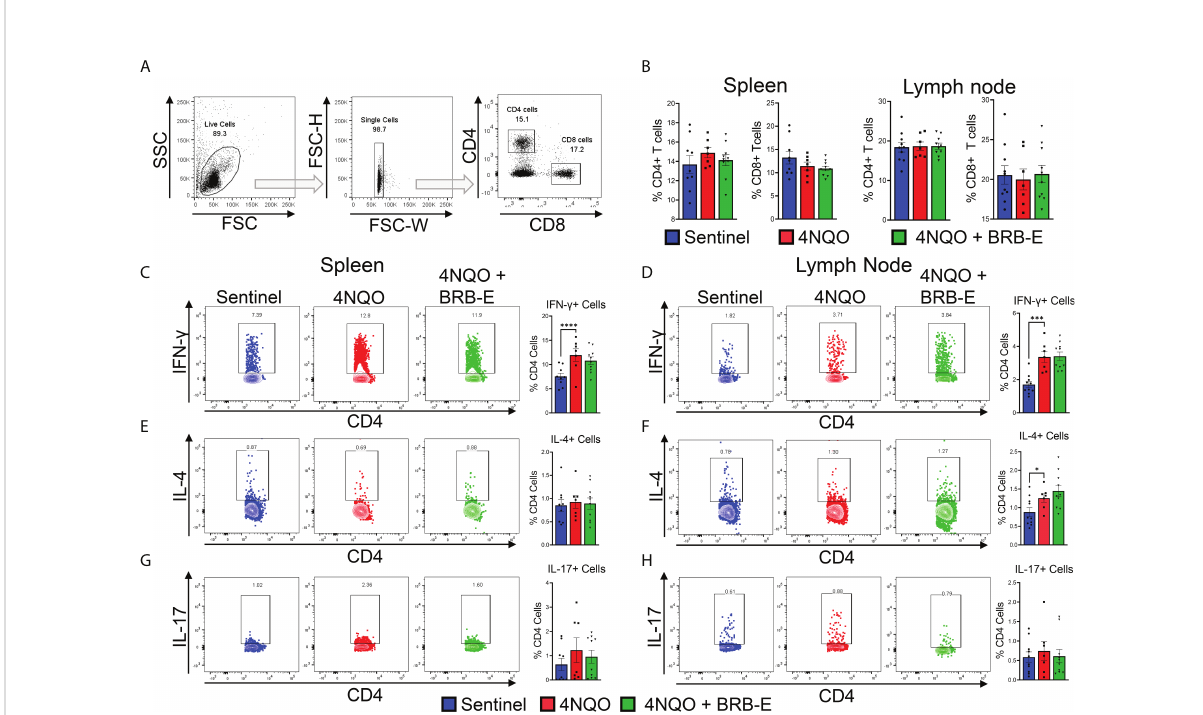
FIGURE 2 Effect of black raspberry extract on CD4 T-cell differentiation during HSNCC chemoprevention. (A) Gating strategy utilized to identify CD4 + and CD8 + T cells from the draining cervical lymph nodes or spleens of HNSCC tumor-bearing or sentinel mice by fl ow cytometry. (B) Proportions of CD4+ and CD8+ T cells in spleens and lymph nodes of non-carcinogen-induced mice (sentinel) and carcinogen-induced mice fed the control AIN76 diet (4NQO) or the BRB-E-supplemented diet (4NQO+BRB-E). (C – H) CD4 + T cells were examined by fl ow cytometric analysis for the presence of intracellular IFN- g (C and (D) , IL-4 (E, F) , or IL-17 (G, H) in spleens (C, E, G) and lymph nodes (D, F, H) of mouse groups. Flow plots show a representative sample of the individual groups. Legend is applicable for B – H. * p -value < 0.05;; *** p -value < 0.001; **** p -value < 0.0001 for comparisons of BRB-E treatment groups to 4NQO-exposed control diet group using Student ’ s t